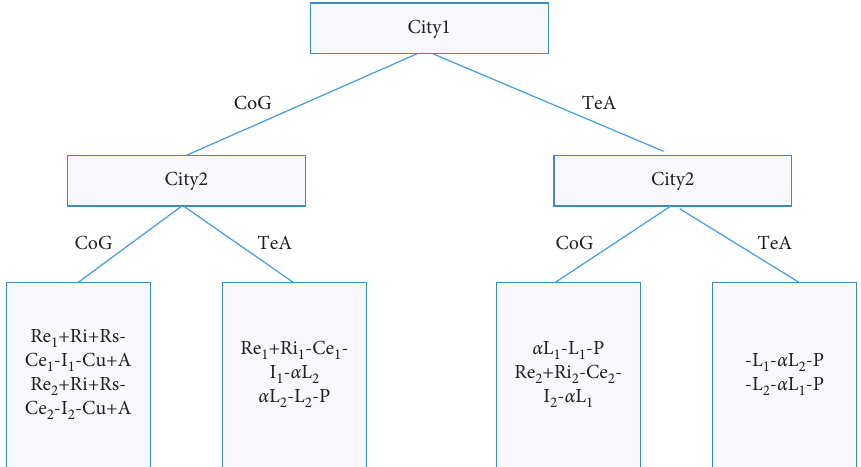
Figure 5: The game tree of city 1 and city 2 under central supervision. CoG represents the strategy “cooperative control” and TeA represents “territorial